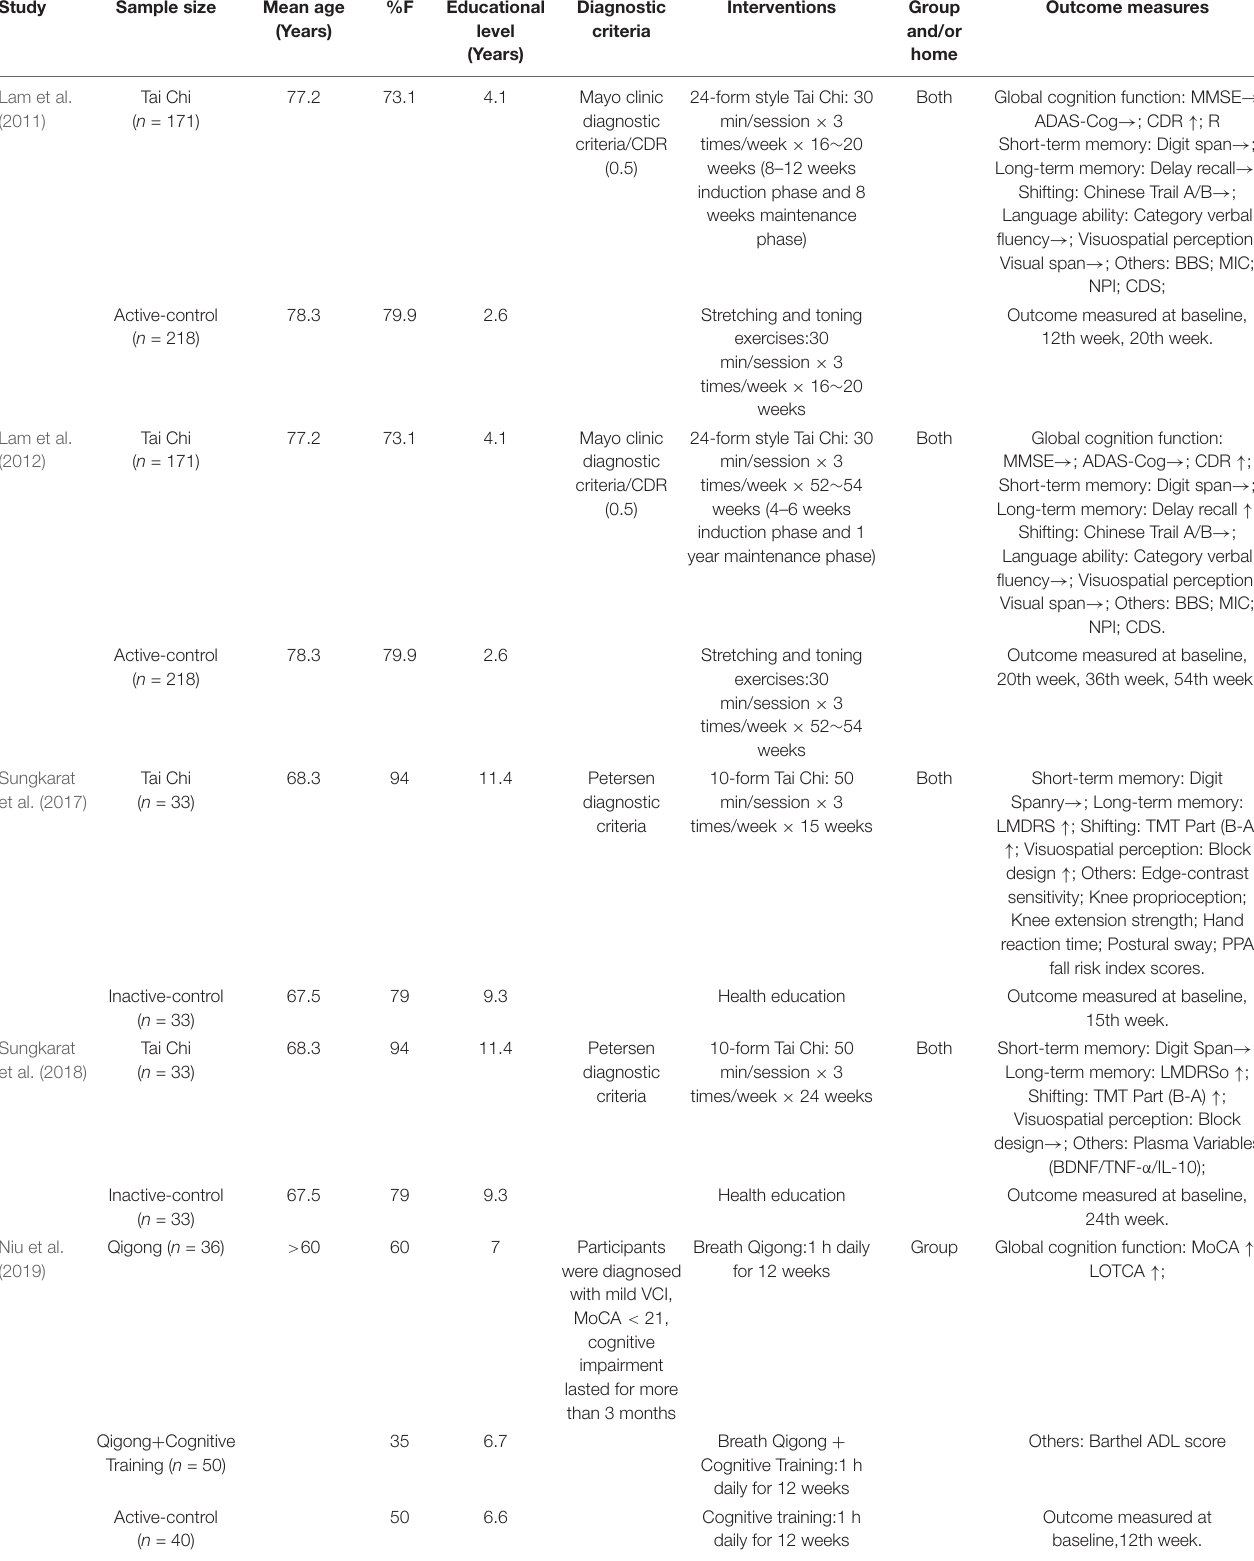
TABLE 1 | Characteristics of the included studies ( n =